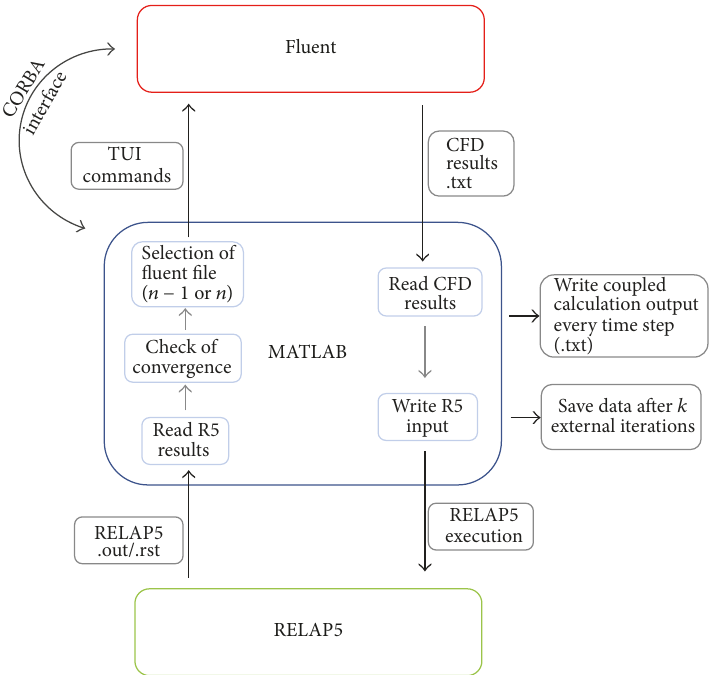
Figure 3: Coupled code management through the MATLAB